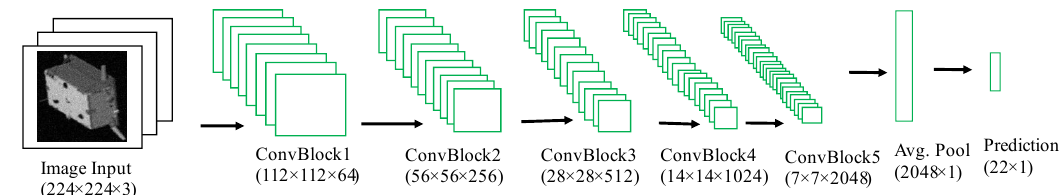
Figure 4. ResNet50 Architecture for Direct Regression.